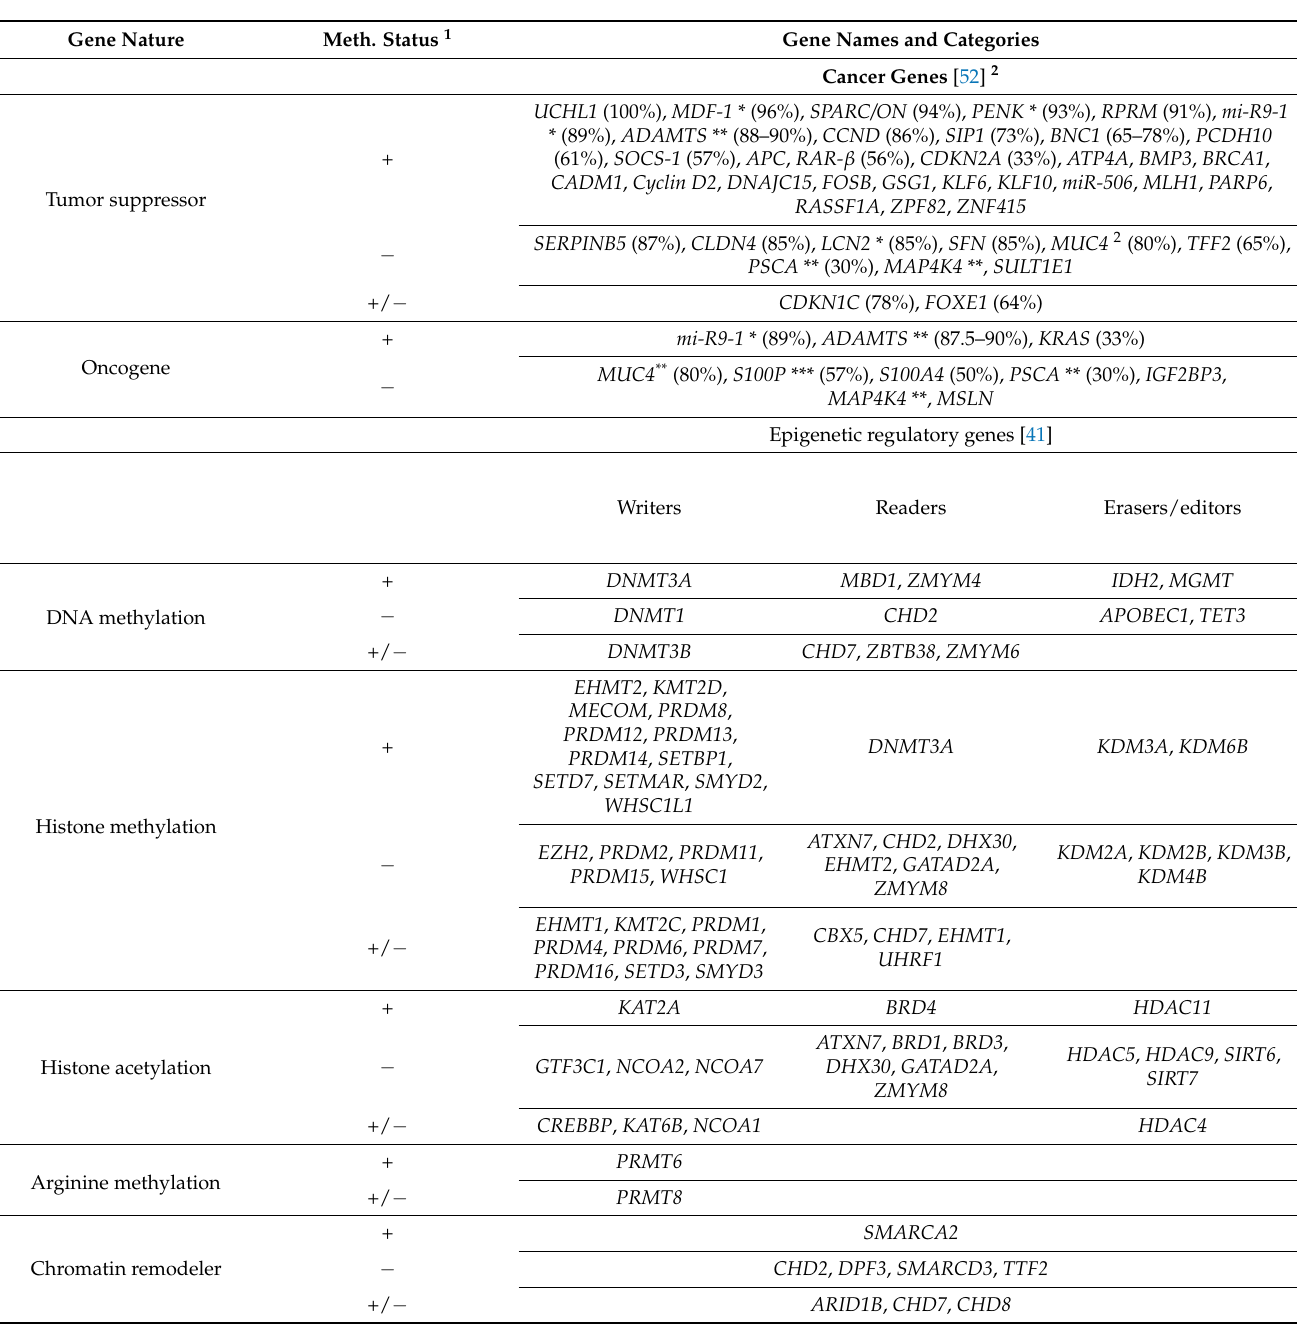
pathway enrichment analysis of differentially methylated genes, enrichment was seen in members of the WNT pathway [48], signaling pathways connected to apoptosis, cell cycle and cell differentiation, cytoskeleton structure, immune- and DNA damage-response, as well as major pancreatic signaling pathways including Notch, Hedgehog and TGF-beta-related genes [41]. An overview of differential methylations in PDAC is shown in Table 2. Table 2. Overview of differentially methylated genes in PDAC tissue. Compiled and modified from [41,52] and references